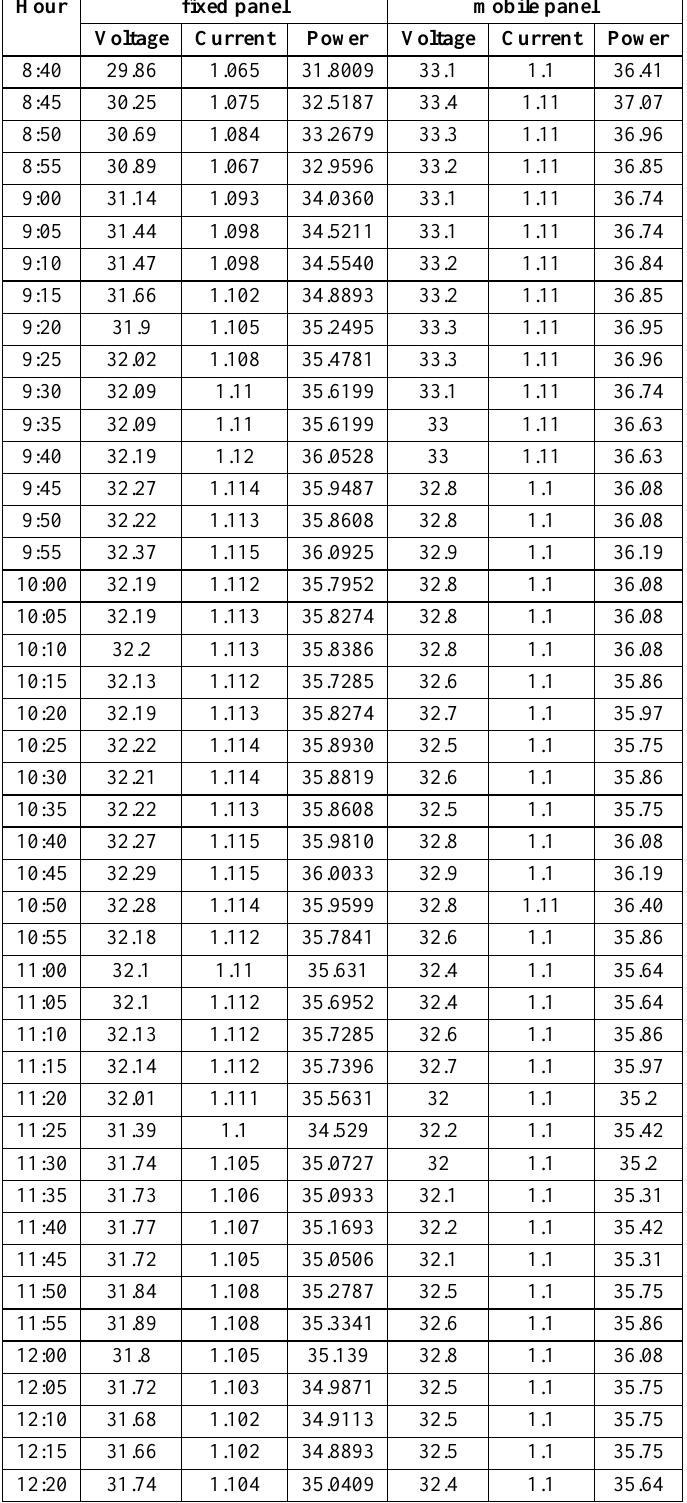
Table 11: Comparative measurements of the first